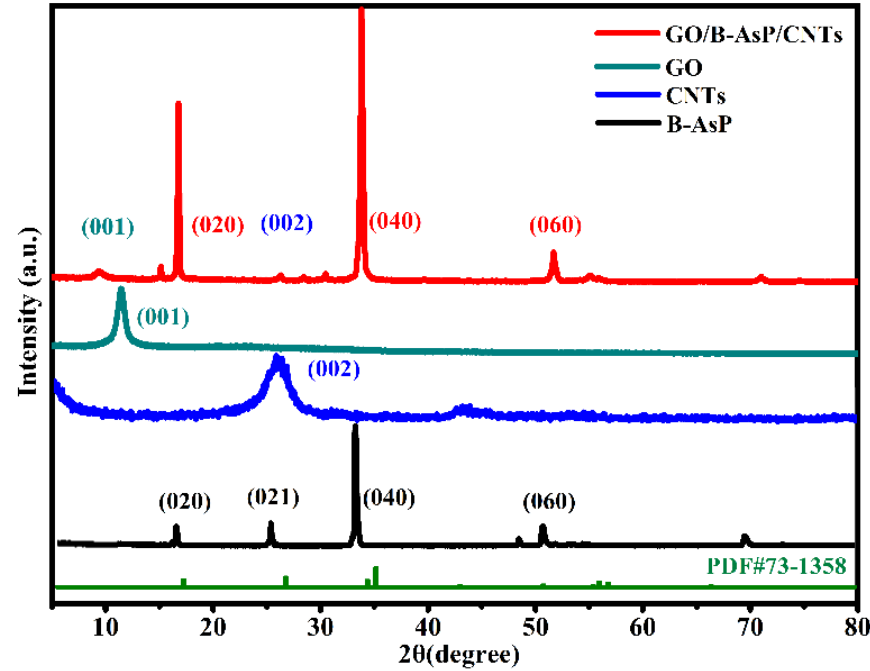
Figure 1. XRD patterns of B-AsP, CNTs, GO, and GO/B-AsP/CNTs. Figure 2 shows the Raman spectra of the GO and GO/B-AsP/CNTs composite samples. There were three major peaks in the B-AsP spectra at 226, 242, and 256 cm − 1 , which corresponded to out-of-plane vibration modes of Ag 1 , and in-plane vibration modes B 2g , and Ag 2 . These peaks were consistent with the previous report [44,45]. In the spectrum of GO/B-AsP/CNTs, in addition to the three major peaks of B-AsP, the D and G bands of GO were clearly observed at 1345 and 1582 cm − 1 , which was consistent with the Raman spectra of GO, as observed [46,47]. The D peak was stronger than the G peak, indicating that there were some oxygen-containing functional groups on GO. In the composite, the characteristic peaks of GO, B-AsP, and CNTs exist at the same time, which was consistent with the XRD analysis. At the same time, as presented in Figure 2, the characteristic peak of P-C bonds appeared at 600-900 cm − 1 . P-C bonds strengthened the connection between the B-AsP and carbon